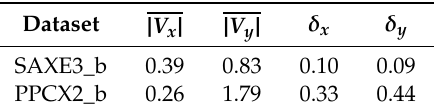
Table 7. Mean absolute velocity and uncertainty δ of the two motion directions for two considered datasets; data are expressed in